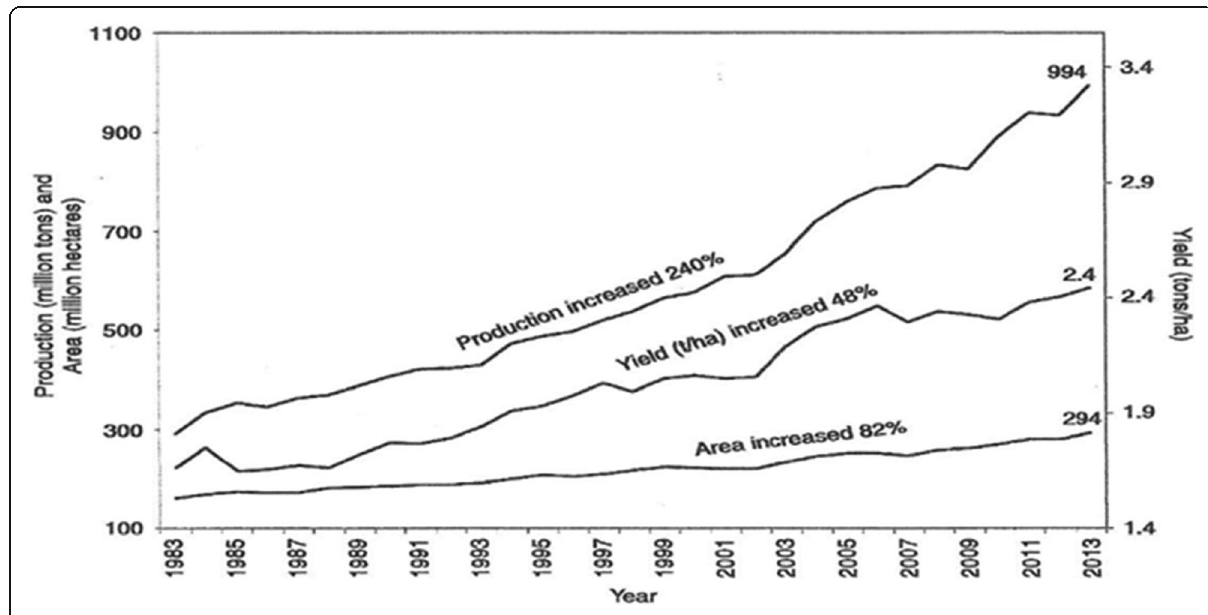
Fig. 1 World trends in oil crop production, yield, and growing area over the last 30 years. [Source: FAOSTAT (FAOSTAT,